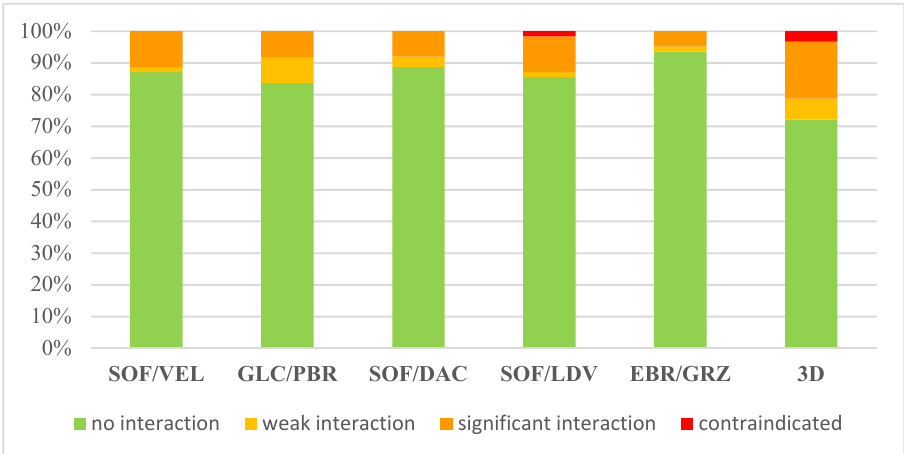
Figure 3. Expected drug-drug interactions between outpatient medications and DAA (ART not included).